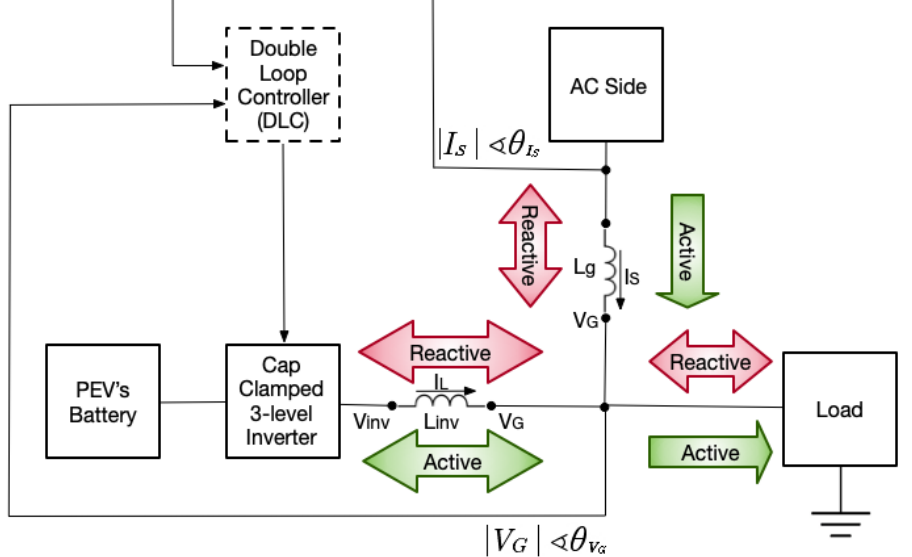
Figure 1. Power flow of the AC grid and PEV battery for both active and reactive power compensation modes controlled by three-level capacitor clamped